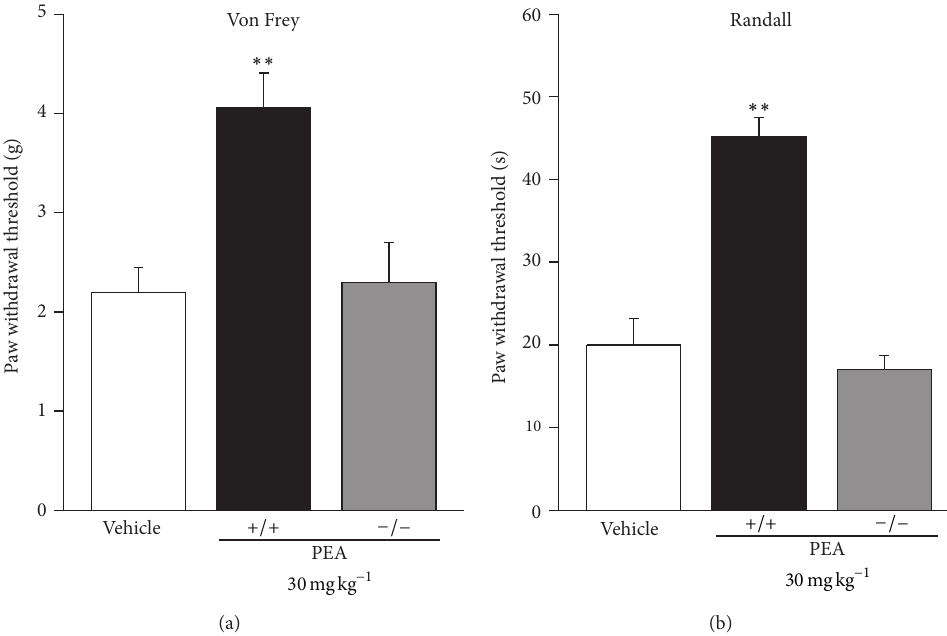
Figure 1: Chronic treatment effects on pain behaviour. Comparison of PEA-effects in PPAR- 𝛼 +/+ and −/− mice. (a) Response to a mechanical noxious stimulus on the ipsilateral paw 14 days after CCI evaluated by Randall-Selitto test. (b) Response to a mechanical nonnoxious stimulus evaluated by Von Frey test. PEA (30mgkg −1 ) was daily s.c. administered for 14 days starting from the day of operation. Each value represents the mean of 2 experiments with 12 mice per group. ∗∗ 𝑃 < 0.01 versus vehicle-treated